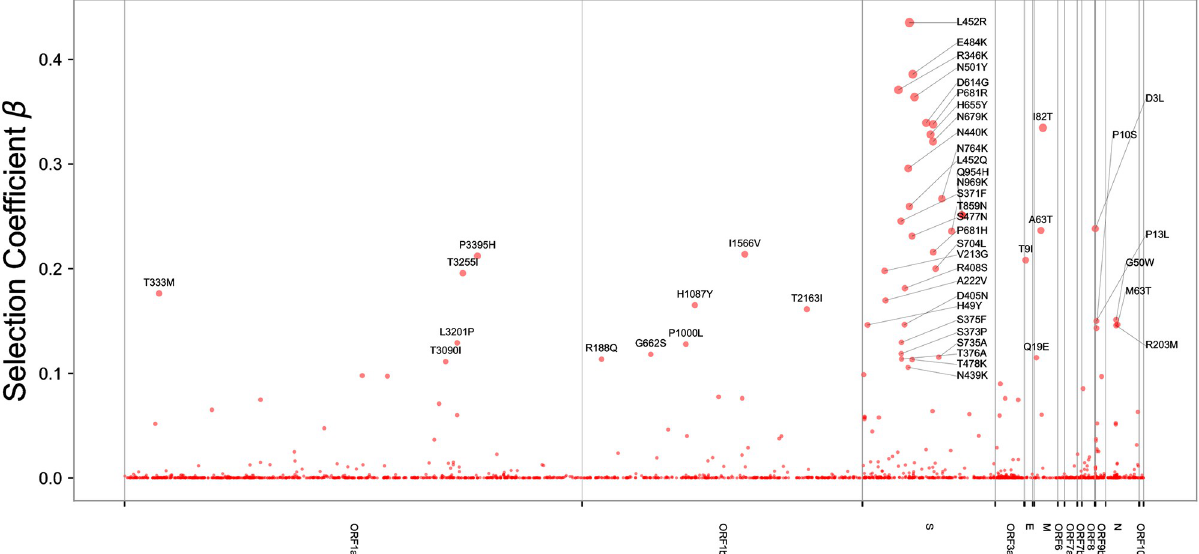
Fig 7. Genome-wide Manhattan plot. We depict BVAS hits as a Manhattan plot of the entire SARS-CoV-2 genome, with gene boundaries indicated on the horizontal axis. We do not include the small number of hits with negative selection coefficients (in particular ORF1b:K1383R, ORF1a:A2554V, ORF1b:S959P, and ORF1a:G697R).